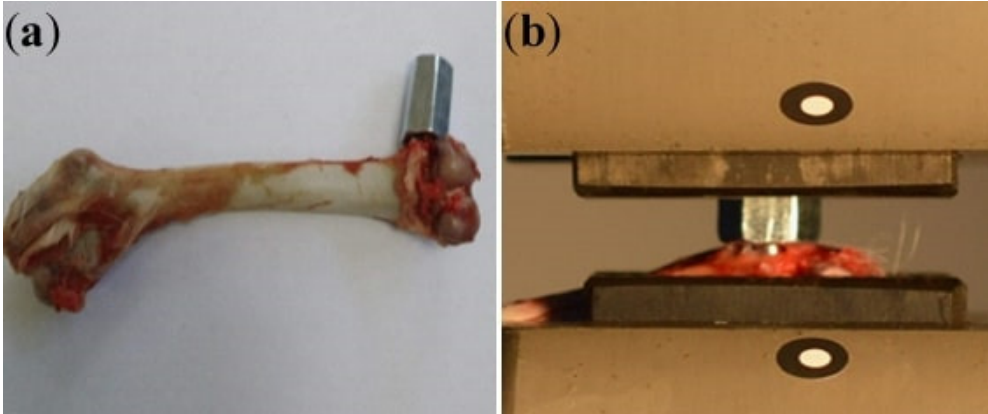
Figure 4. Tensile pull-out measurement: photographs of ( a ) the hexagonal adaptor attached to the 3D Ti implant, and ( b ) both the femur and the adaptor attached to the 3D metallic implant, in the traction machine support.